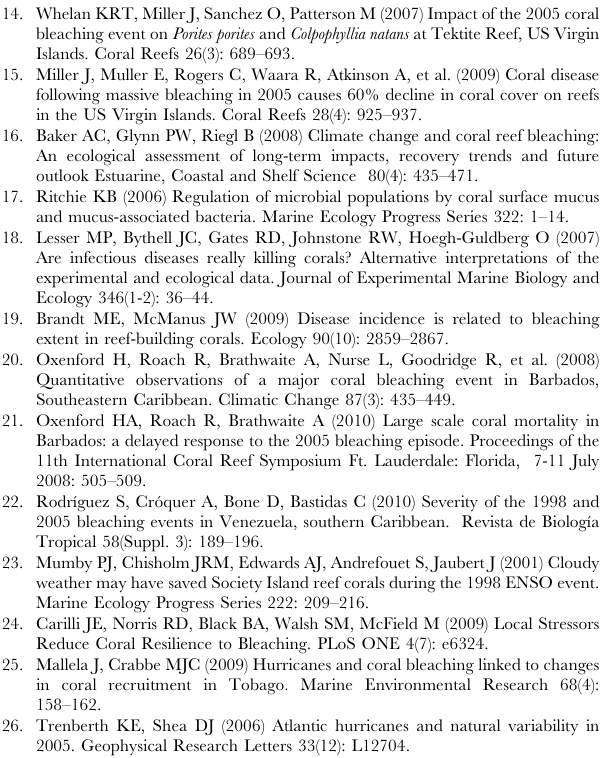
Figure 4 were averaged across reef-containing pixels (2-degree resolution) within the region [91W-55W, 5N-35N] and are presented as anomalies relative to the 1901-2000 mean. Figure S1 Sea surface temperature during the 2005 Caribbean bleaching event. Sea surface temperature (SST) averaged across the 0.5-degree pixels that contained or were nearest Caribbean reef locations (bounded by 35 u N, 55 u W, 5 u N and the coast of the Americas). The ‘ + ’ symbols indicate the average climatological temperature during each month and the dashed line shows the maximum of these, an indication of the expected warmest (usually summer) temperature. The SST trace shows that, on average, temperatures around Caribbean reefs exceeded climatological values by close to 1 u C for a period of more than four months. The magnitude and extended duration of the basin-wide thermal anomaly resulted in widespread coral bleaching and lowered the ability of corals to resist other disease conditions. Figure S2 Animation of the development of thermal stress during the 2005 Caribbean bleaching event, measured using NOAA Coral Reef Watch Degree Heating Week product from 4 June 2005 to 14 February 2006 with a pause during the peak of the event at 28 October 2005. Found at: doi:10.1371/journal.pone.0013969.s002 (5.54 MB Figure S3 Locations of 2575 bleaching surveys submitted from sites across the greater Caribbean region. Colors denote number of surveys at each of the 1212 sites. See Table S1 for location details.